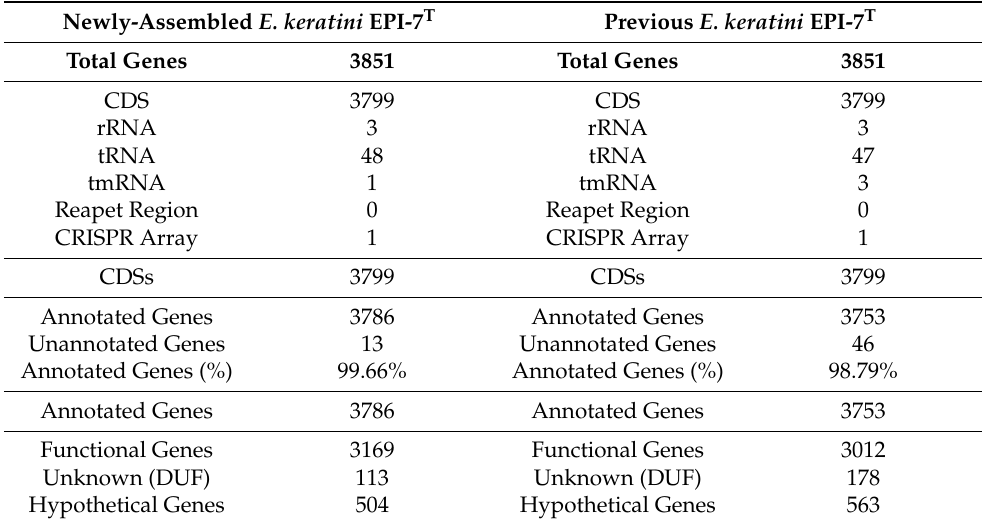
Table 2. Comparison of annotations between newly-generated and previous E. keratini EPI-7 T . Newly-Assembled E. keratini EPI-7